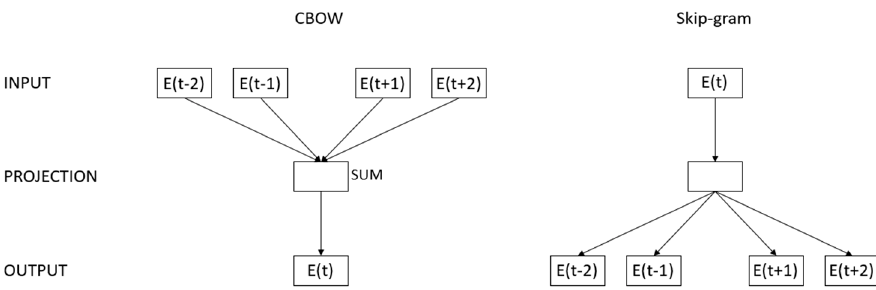
Figure 3. Graphic representation of CBOW and Skip-gram model with a context window of two elements in the past and two in the future.